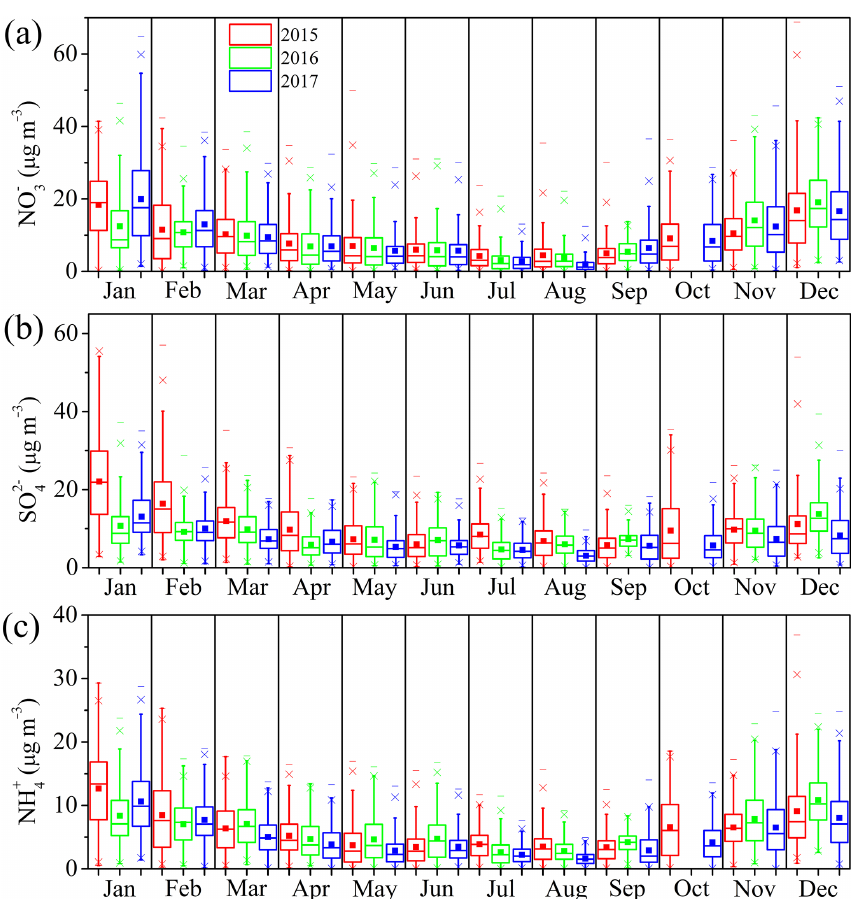
Figure 3. Monthly variations in NSA (nitrate, sulfate and ammonium) concentrations from 2015 to 2017. (a) NO −